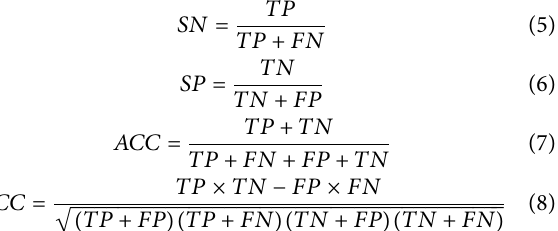
Frontiers in Genetics |